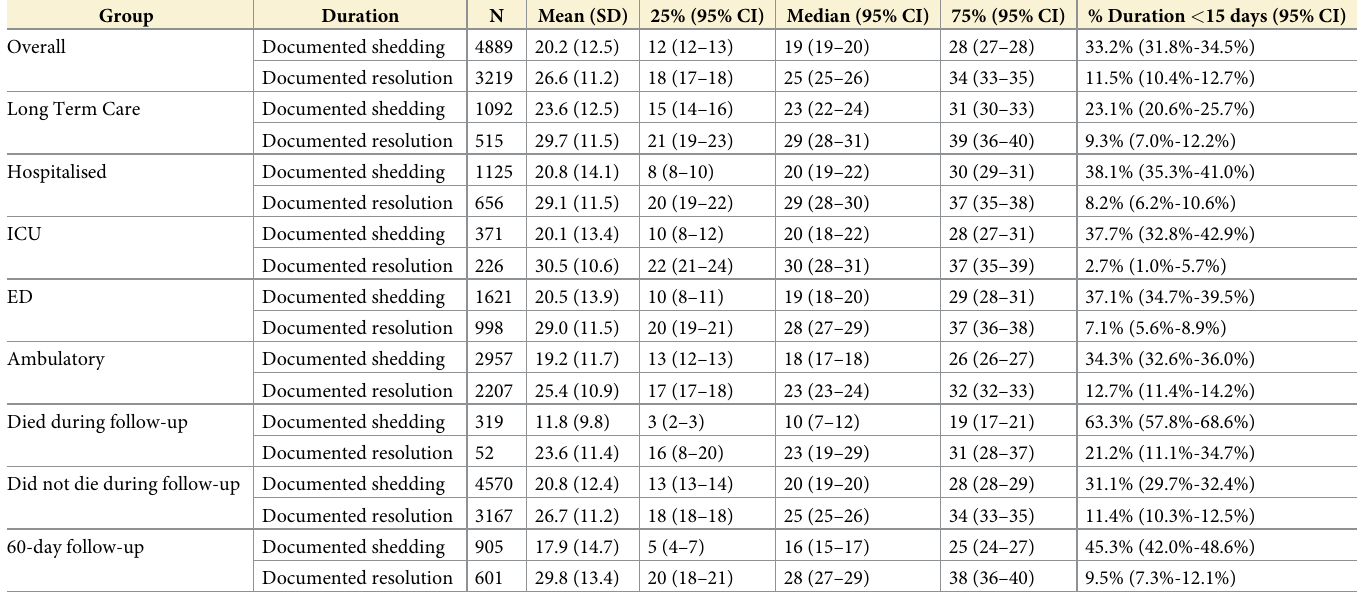
Table 2. Shedding duration distribution summary descriptions for the documented shedding (no test resolution) and documented resolution (two negative PCR tests after a positive) duration definitions, overall study population and by